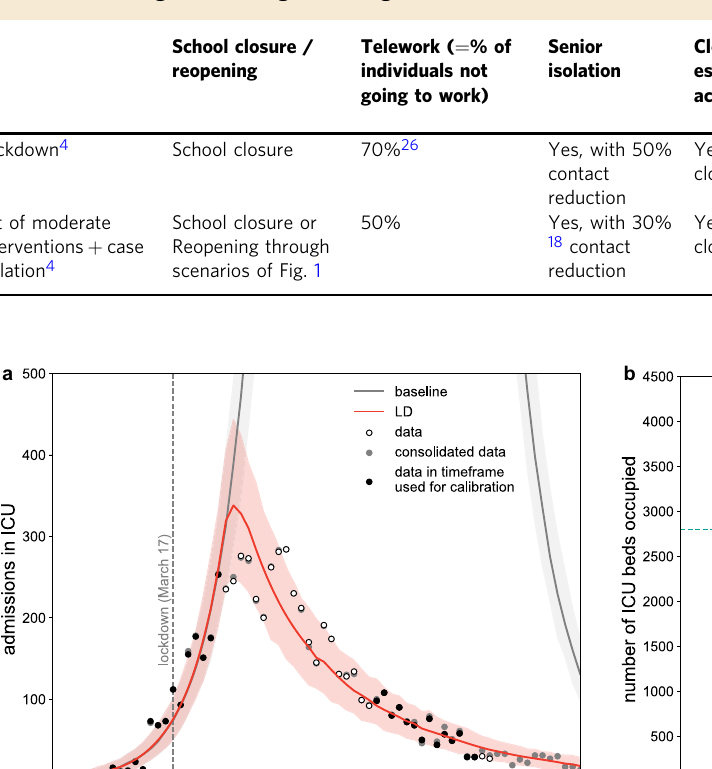
Table 1 Exit strategies following the lifting of the lockdown.